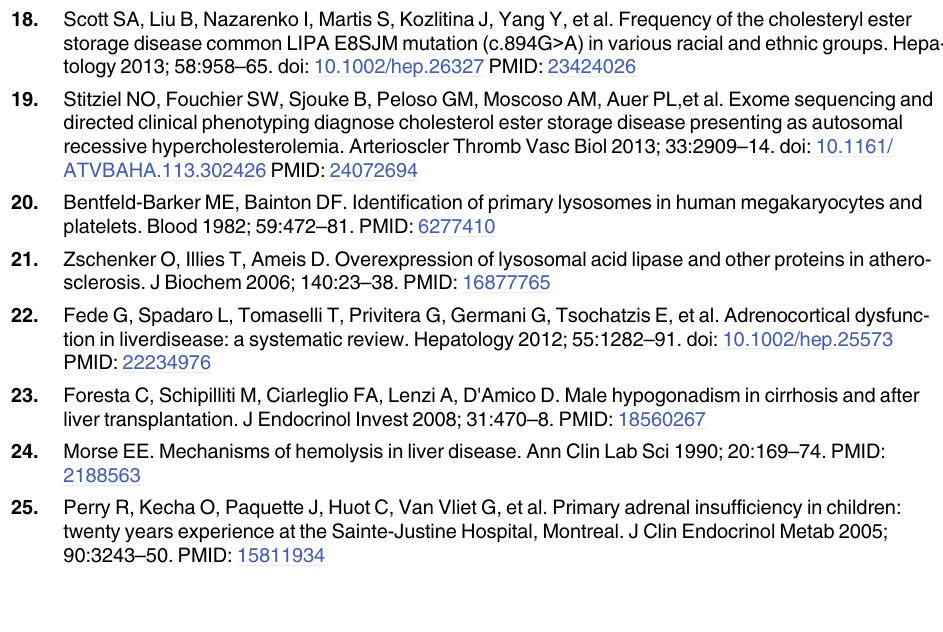
PLOS ONE | DOI:10.1371/journal.pone.0156113 May 24,